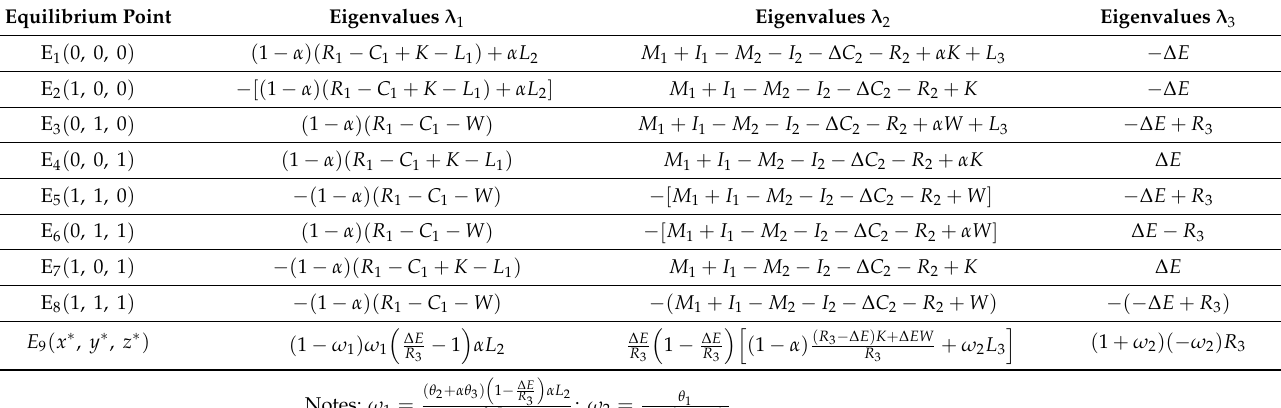
Table 2. Eigenvalues of the Jacoby